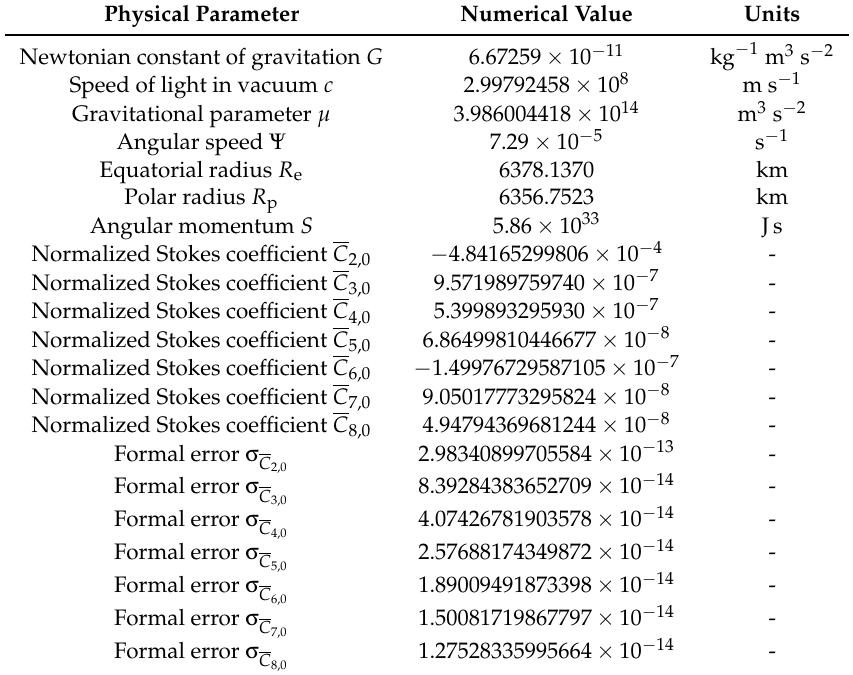
Table A1. Relevant physical parameters of the Earth [50–52]. The zonal harmonics of the geopotential −√ of degree (cid:96) are given by J (cid:96) = 2 (cid:96) + 1 C (cid:96) ,0 , (cid:96) = 2,3,4, . . ., where C (cid:96) ,0 , (cid:96) = 2,3,4, . . . are the fully normalized Stokes coefficients of degree (cid:96) and order m = 0 of the multipolar expansion of the Newtonian part of the Earth’s gravity field. The formal, statistical errors in the first seven Stokes coefficients of the geopotential, along with their nominal values, were retrieved from the global gravity field solution Tongji-Grace02s [48] retrievable on the Internet at http://icgem.gfz-potsdam.de/tom_